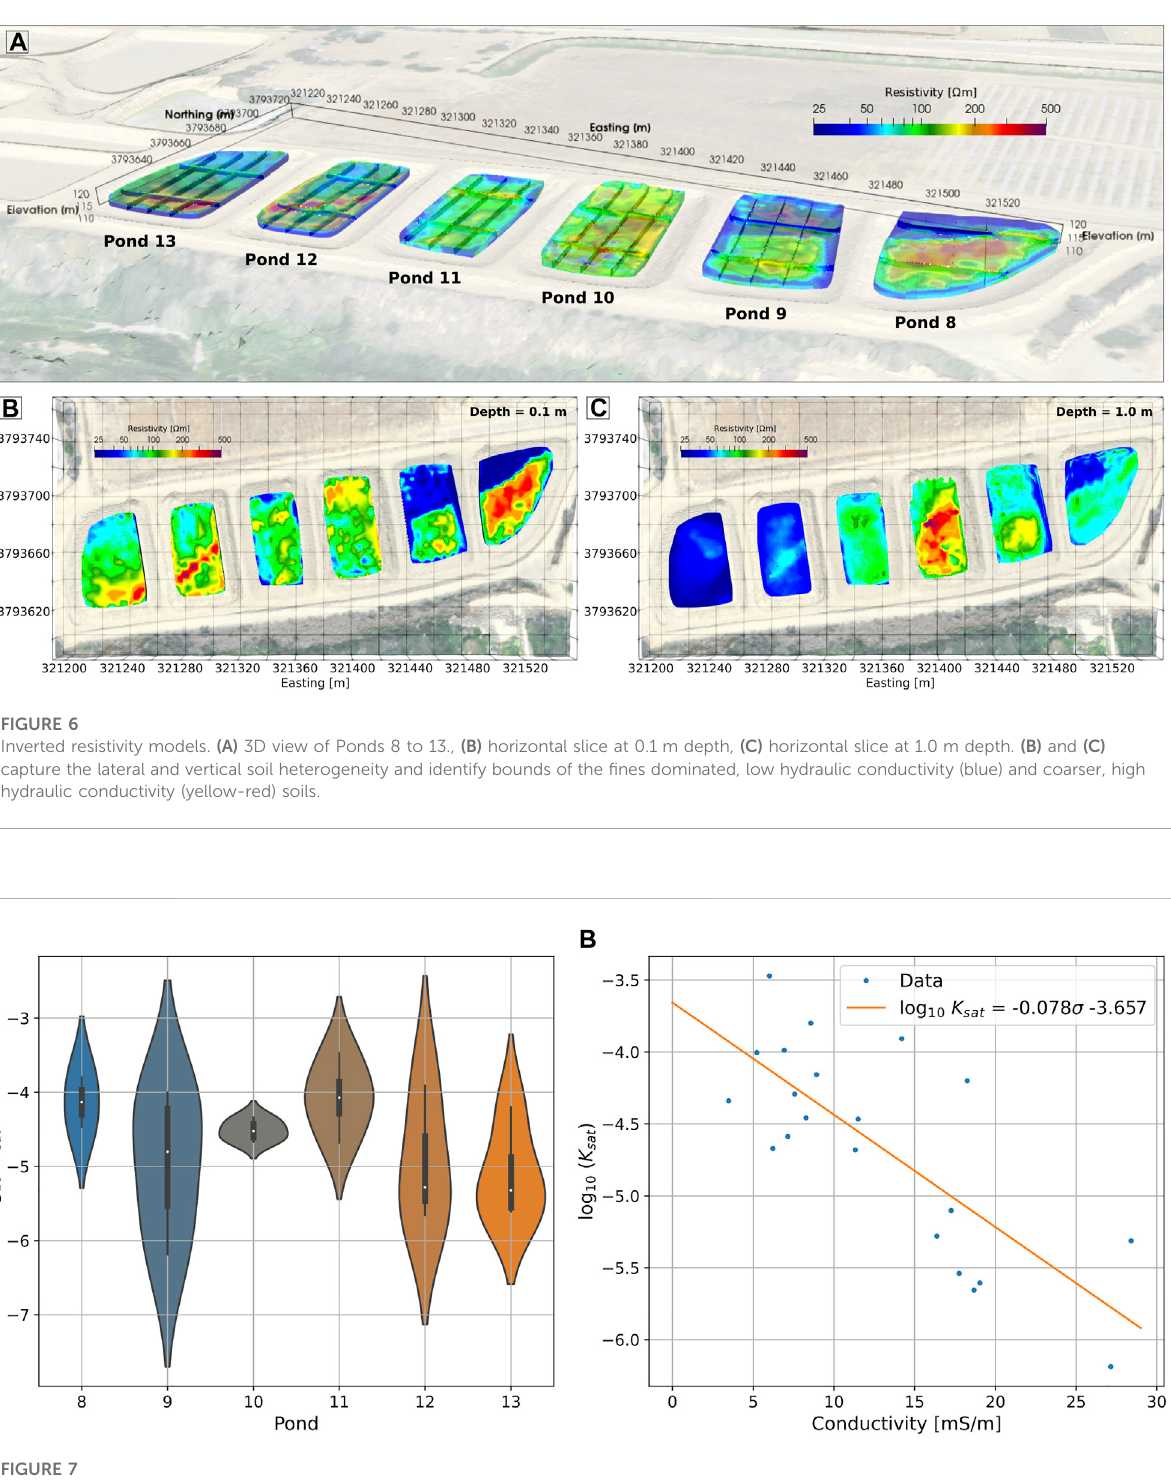
Frontiers in Earth